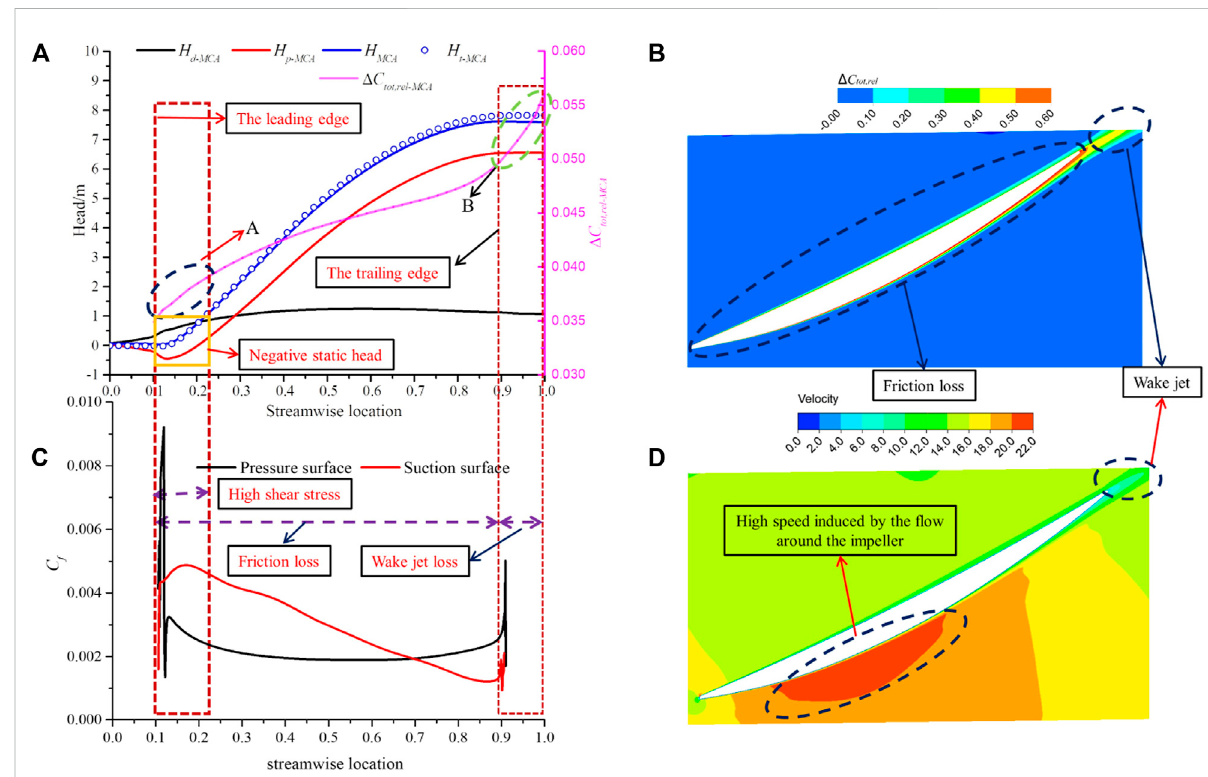
FIGURE 11 The energy transfer and loss mechanism on the surface of R* = 0.5: (A) The distribution curve of the coef fi cients of the head and relative total pressure loss with the fl ow direction coef fi cient; (B) The distribution curve of the friction coef fi cient; (C) The relative total pressure loss coef fi cient contour; (D) The relative velocity contour.